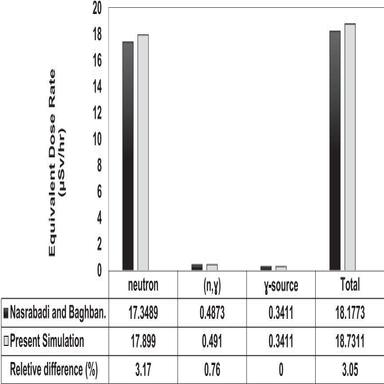
Equivalent dose rate components in reference design.